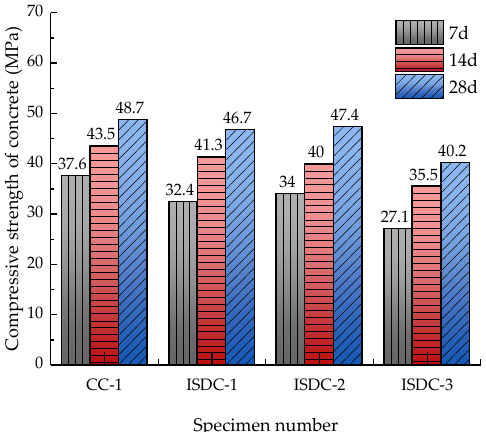
Figure 6. Compressive strength of concrete with different ISD admixtures.